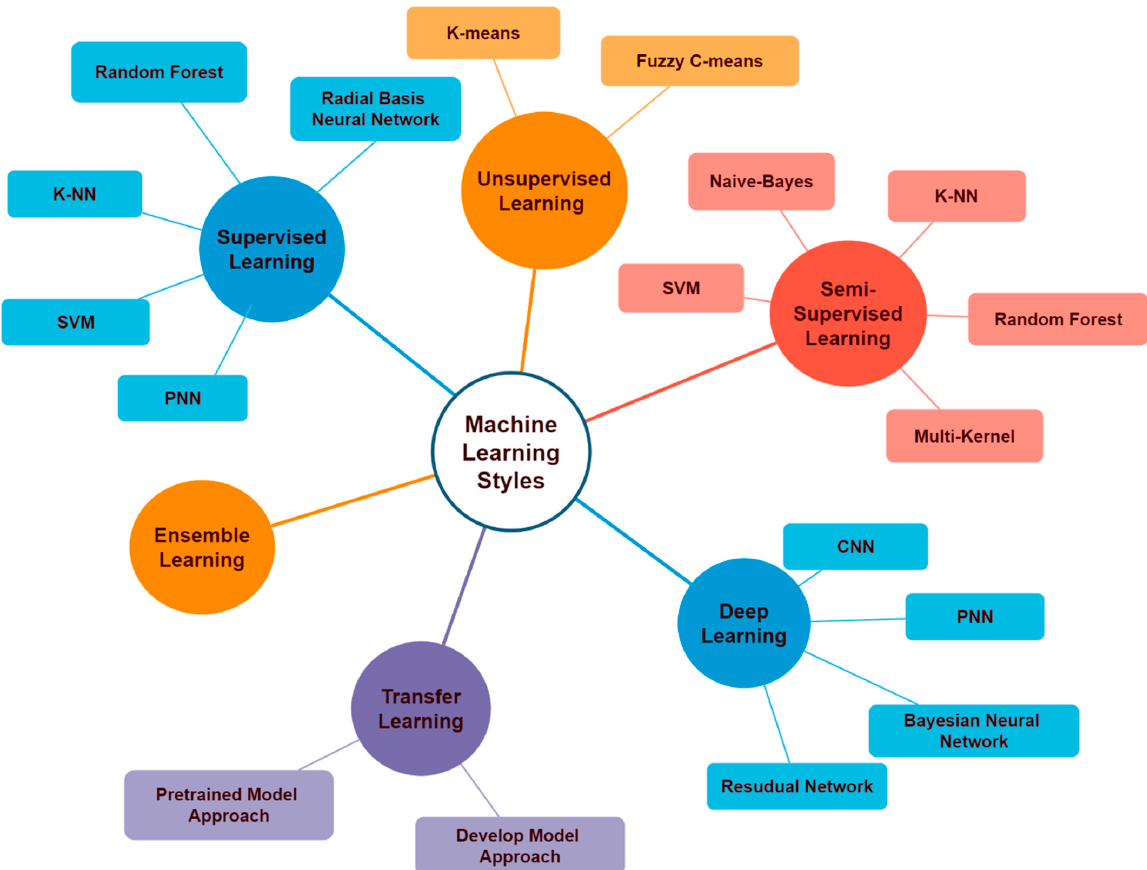
Figure 21. Machine learning styles for DR classification.